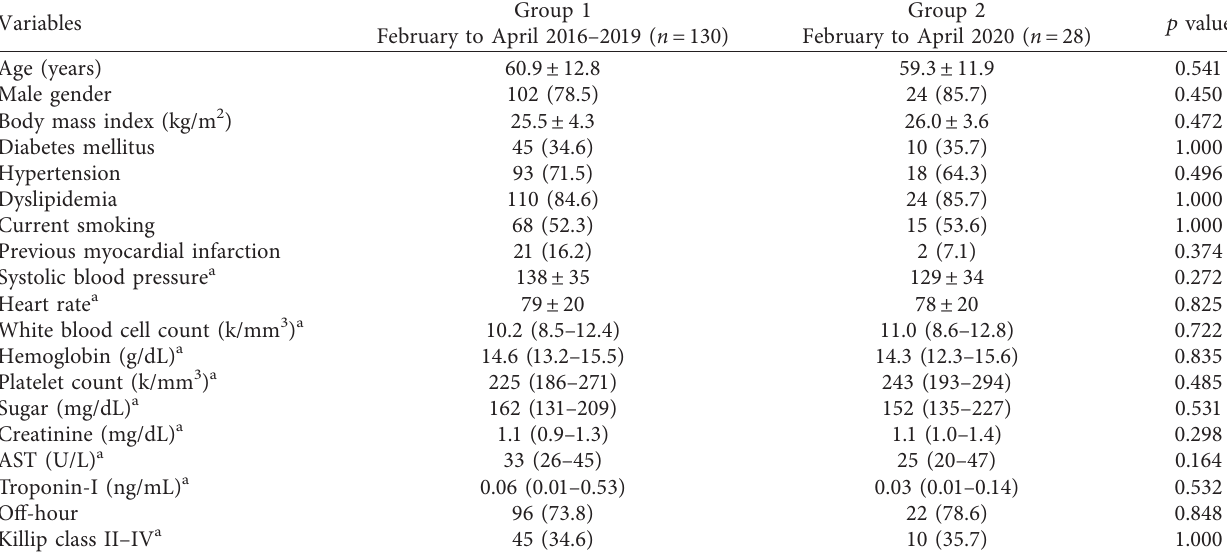
Table 1: Baseline characteristics, vital signs, and laboratory data.